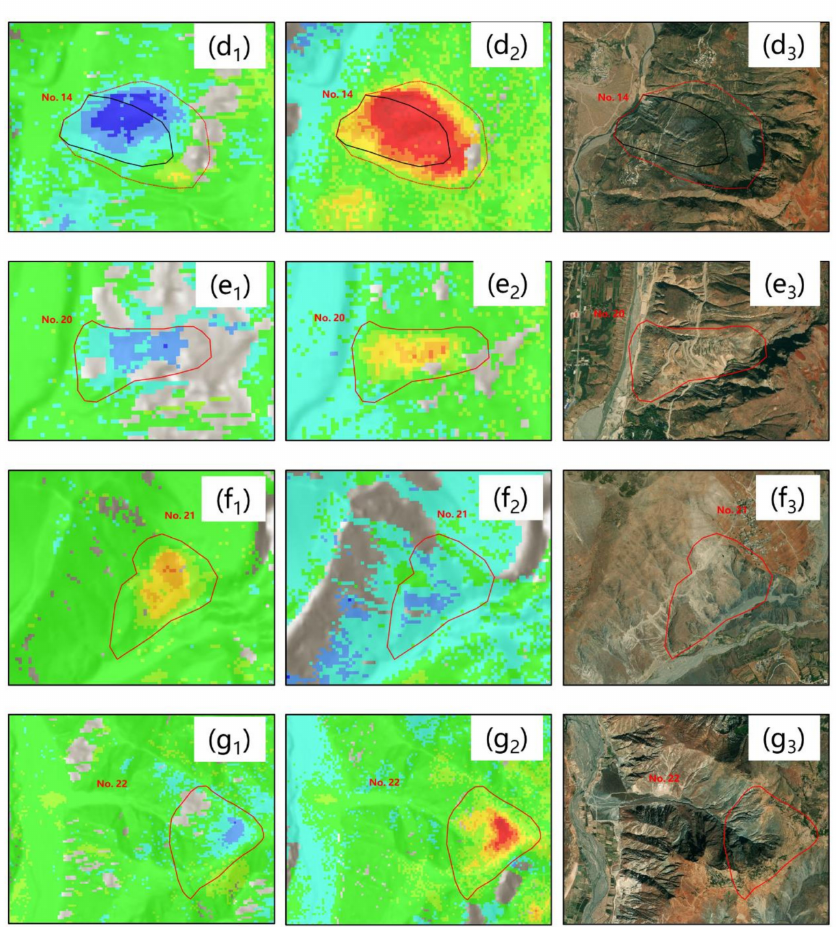
Figure 5. Line-of-sight (LOS) displacement rate maps for the study area derived from ( a ) ascending Sentinel-1 images during March 2017 to May 2019; ( b ) descending Sentinel-1 images during March 2017 to April 2019. White curves map the major historical debris flows, and black curves map the recorded landslides from AGRS. By our approach, five recorded landslides (No. 14, 16–19) have been detected significant expansion of their boundaries, redrawn within red dotted curves; three unrecorded landslides (No. 20–22) have been newly detected and mapped within red curves. ( c – g ) show enlarged views of these landslides, within their ascending observations, descending observations, and optical images for